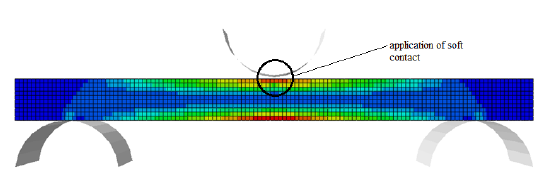
Figure 7. Illustration of position of applied soft contact.